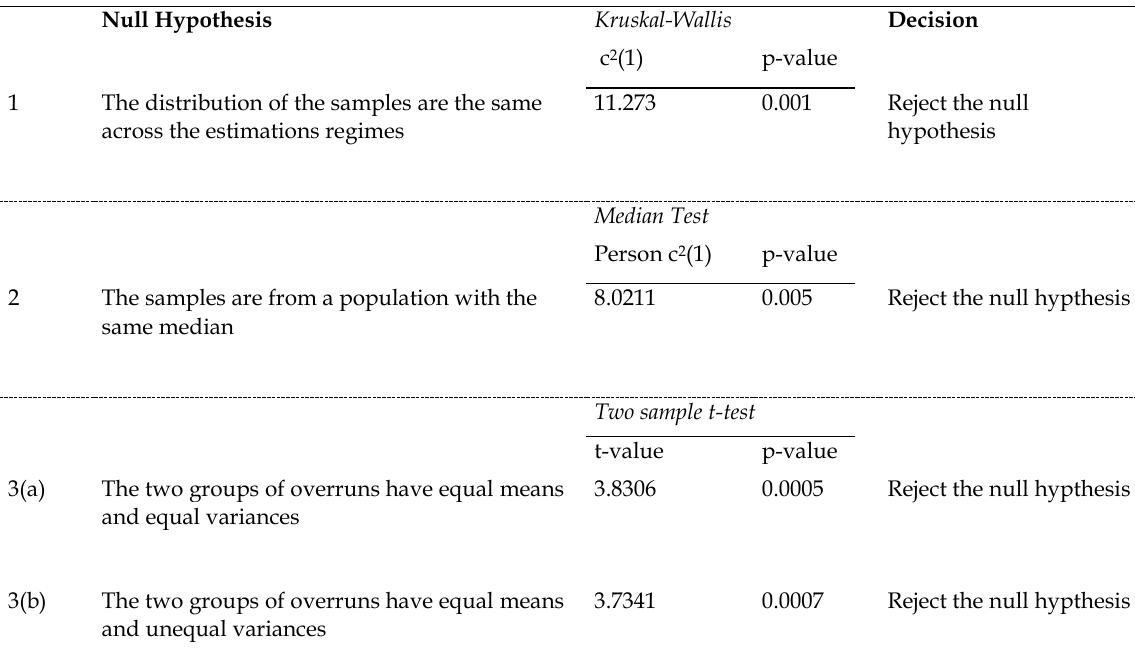
Table 4. Testing for significance of differences in PCO between the pre- and post-quality assurance